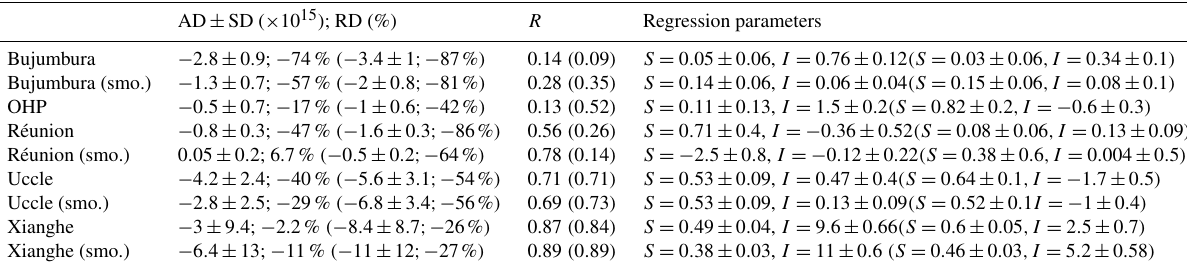
Table 5. Same as Table 4 but for GOME-2B product.